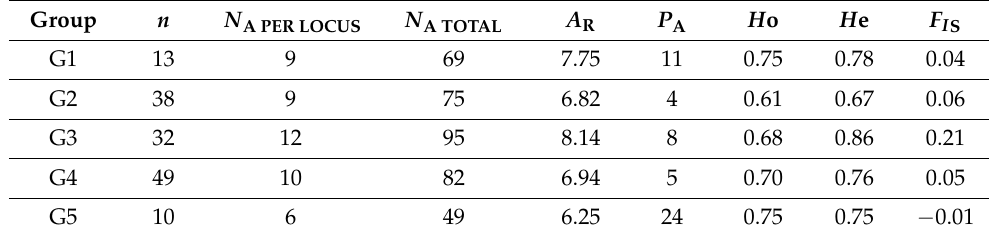
Table 3. Parameters of genetic diversity of the genetic structure ( K = 5) of 115 accessions of interspecific hybrids and 27 reference genotypes using eight SSR markers. Number of alleles ( N A ), allele richness ( A R ), private alleles ( P A ), observed heterozygosity ( Ho ), expected heterozygosity ( He ), and inbreeding coefficient ( F IS